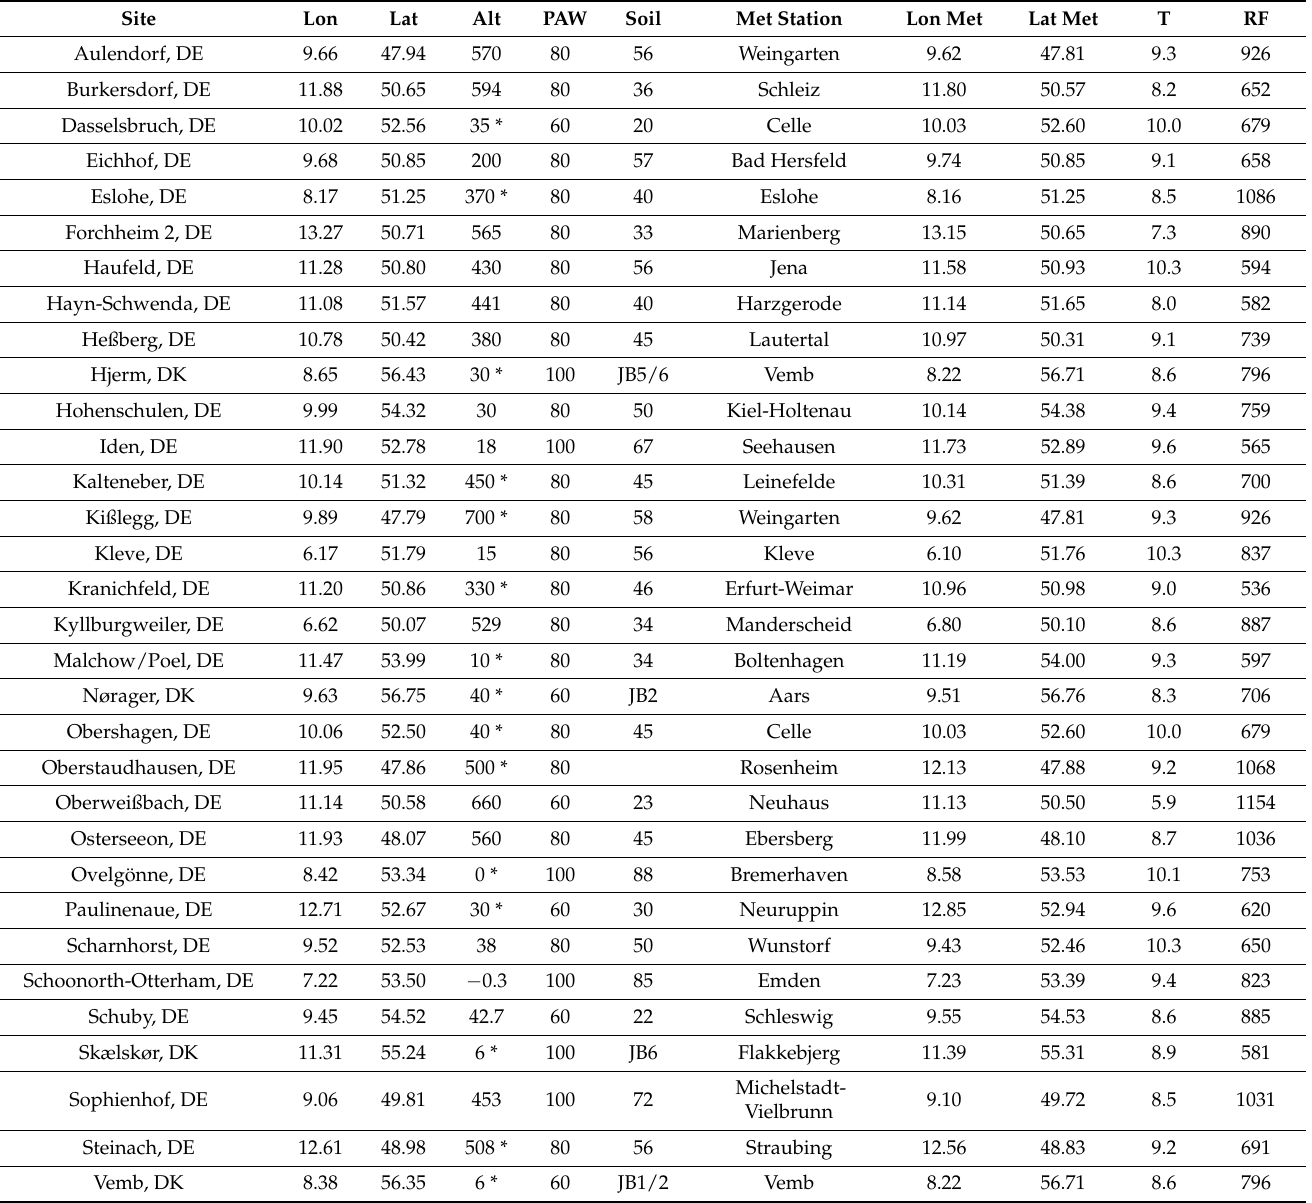
Table 1. Site descriptions and meteorological stations (Met Station) used for the modelling. DWD (=Germany’s National Meteorological Service, Der Deutsche Wetterdienst) was used for the modelling. Lon = longitude, Lat = latitude in degrees, Alt = altitude in meters above sea level, PAW = plant available water (mm) in 500 mm depth, T = mean annual temperature ( ◦ C), mean annual RF = mean annual rainfall (mm), Lon Met = longitude in degrees of the meteorological station, Lat Met = latitude in degrees of the meteorological station, * proximate values. Soil classification (Soil) in Germany (DE) was based on the Ackerzahl [35] and on the Danish soil classification scheme [36] in Denmark